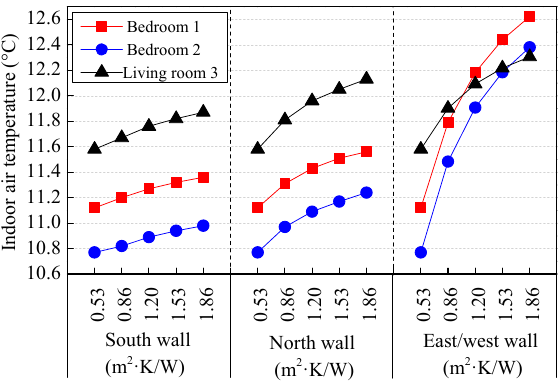
Figure 11. Indoor air temperatures of the main rooms change with the thermal resistance of the exterior walls in mode c.